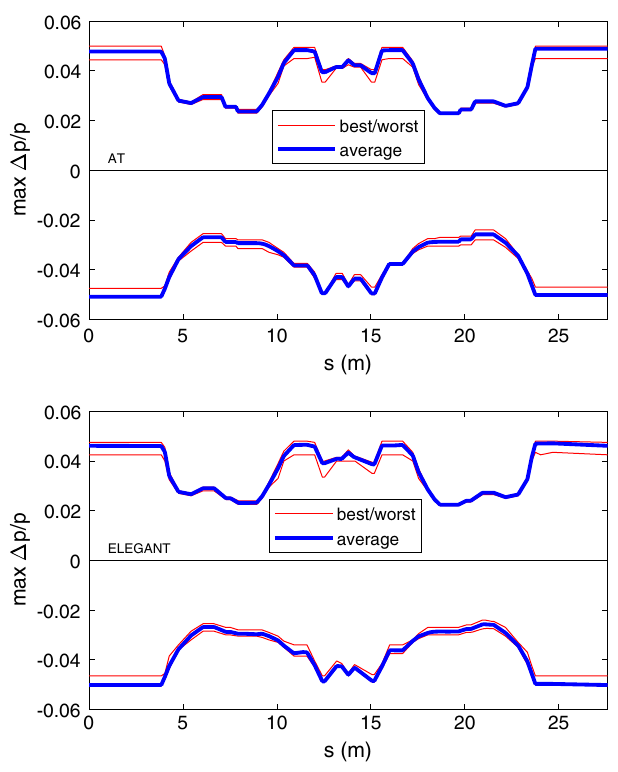
FIG. 12. Local momentum aperture for the first sector of the APS-U lattice with 25 random error seeds obtained with particle tracking by AT (top) or ELEGANT